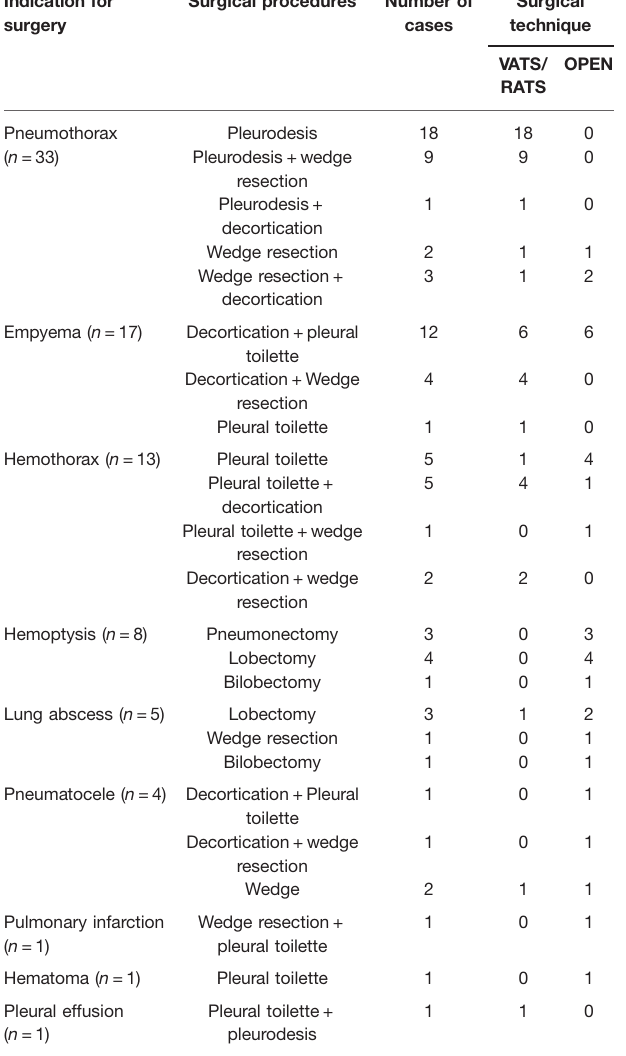
TABLE 2 | Indications for surgery, surgical procedures performed and surgical techniques adopted, in details. Indication for surgery